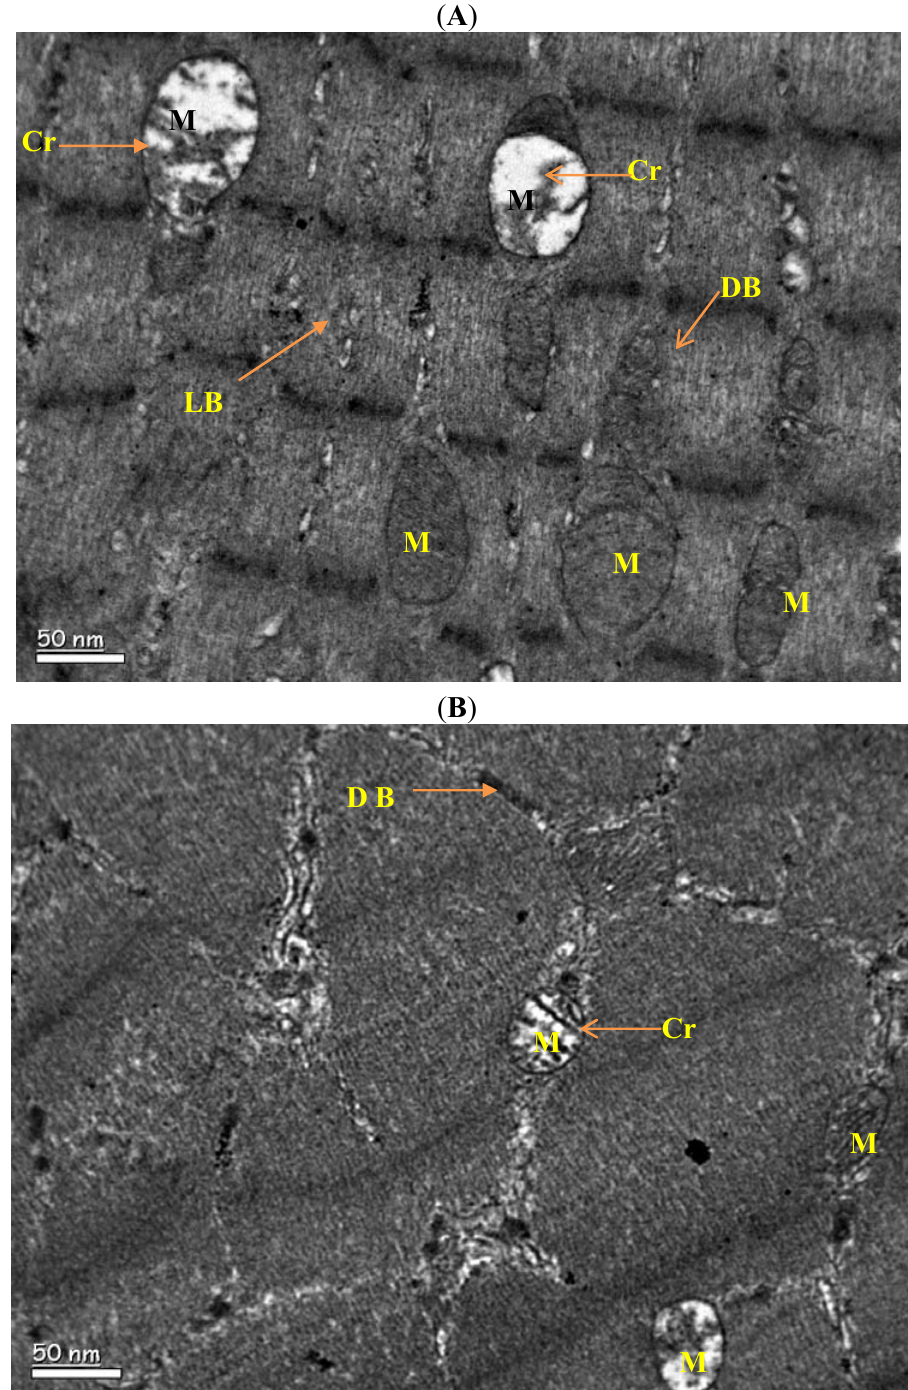
Figure 2. Electron photomicrographs of muscle samples. ( A ) Group I, Normal general ultrastructural appearance of skeletal muscle, note damaged cristae of mitochondria (20,000×). ( B ) Group II, Normal general ultrastructural appearance of skeletal muscle, note normal structure of mitochondria (20,000×). ( C ) Group III, Different in size and damaged cristae of mitochondria within an intermyofibrillar space (20,000×). ( D ) Group IV , Normal general ultrastructural appearance of skeletal muscle, with focal edema within an intermyofibrillar space (20,000×). ( E ) Control, Normal general ultrastructural appearance of skeletal muscle, with normal structure of mitochondria